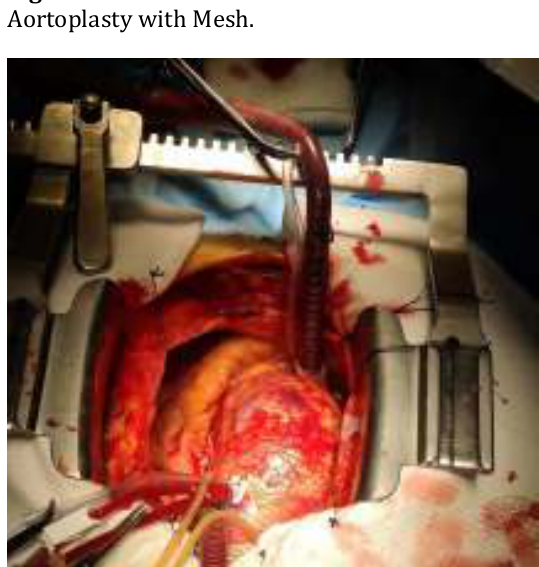
Figure 2: Ascending Aortic